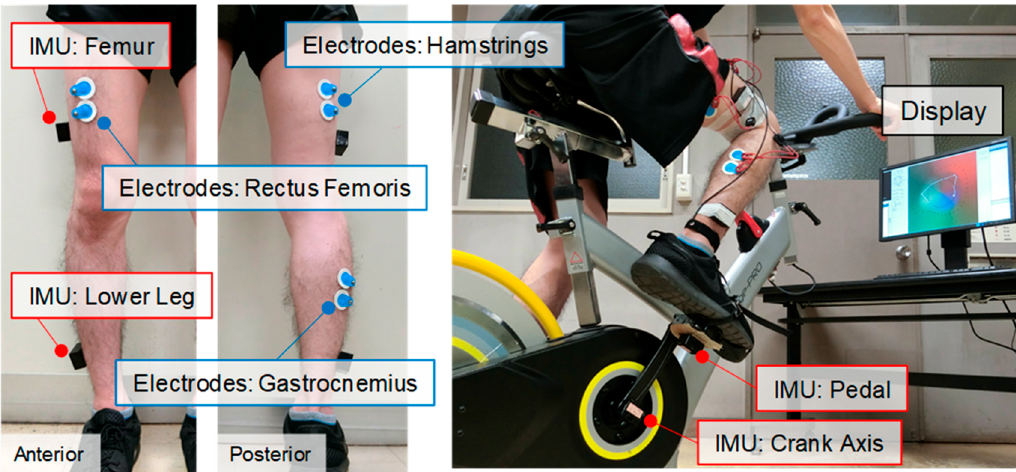
Figure 2. Position of wireless inertial measurement units (IMU) and electromyogram (EMG) sensors during training with visual feedback. Information was recorded for seven motions and processed by the personal computer in real